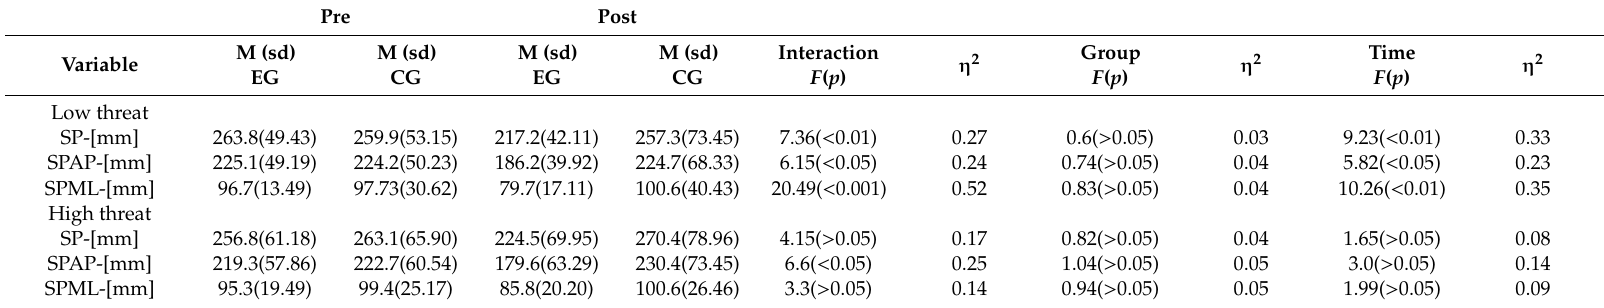
Table 5. Mean and standard deviation values of postural stability for dual-task with eyes closed on low and high threat in the experimental and the control groups before and after intervention and results of two-way